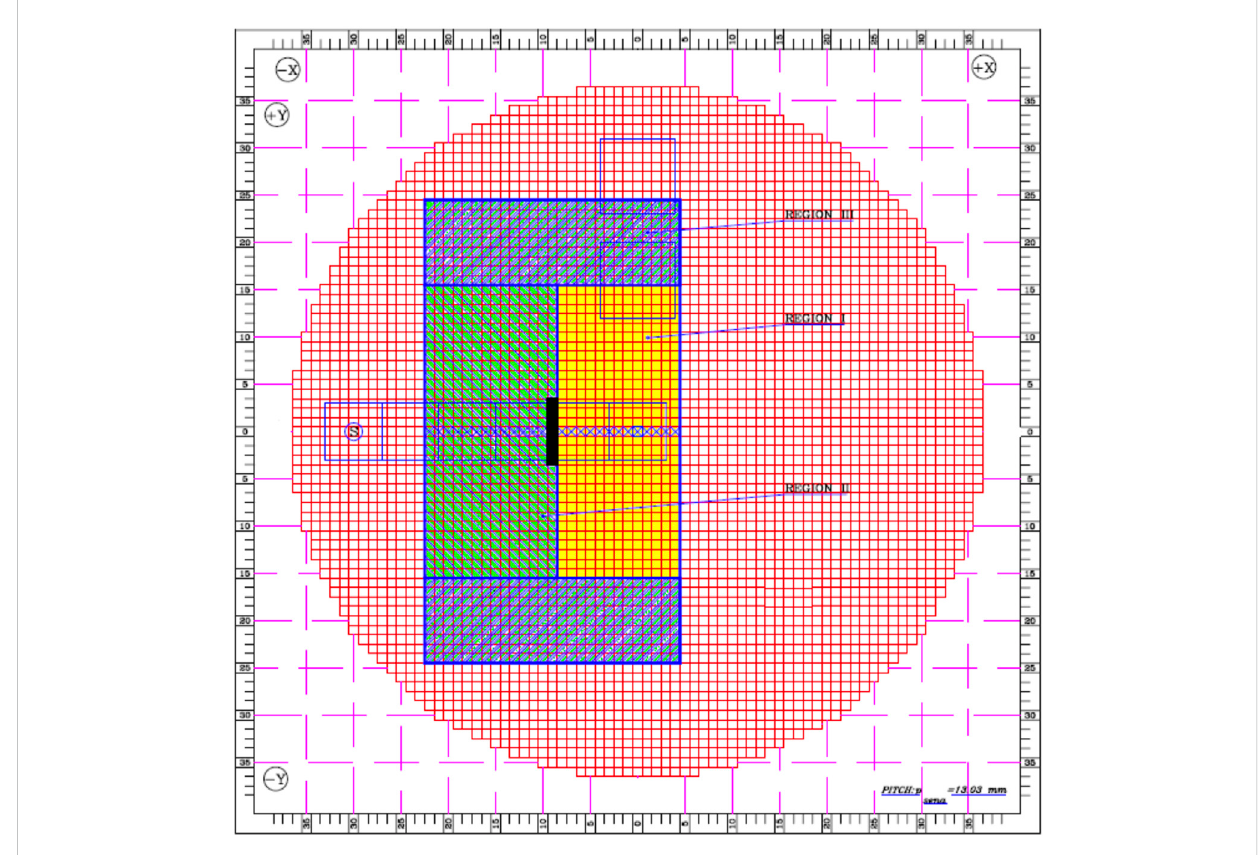
HorizontalHistoricalSchematicofCon fi guration9/1CoreLoadingfromVENUS-PRP(RegionIrepresentsMOXfuelpins;RegionsIIandIIIrepresent UO 2 fuel